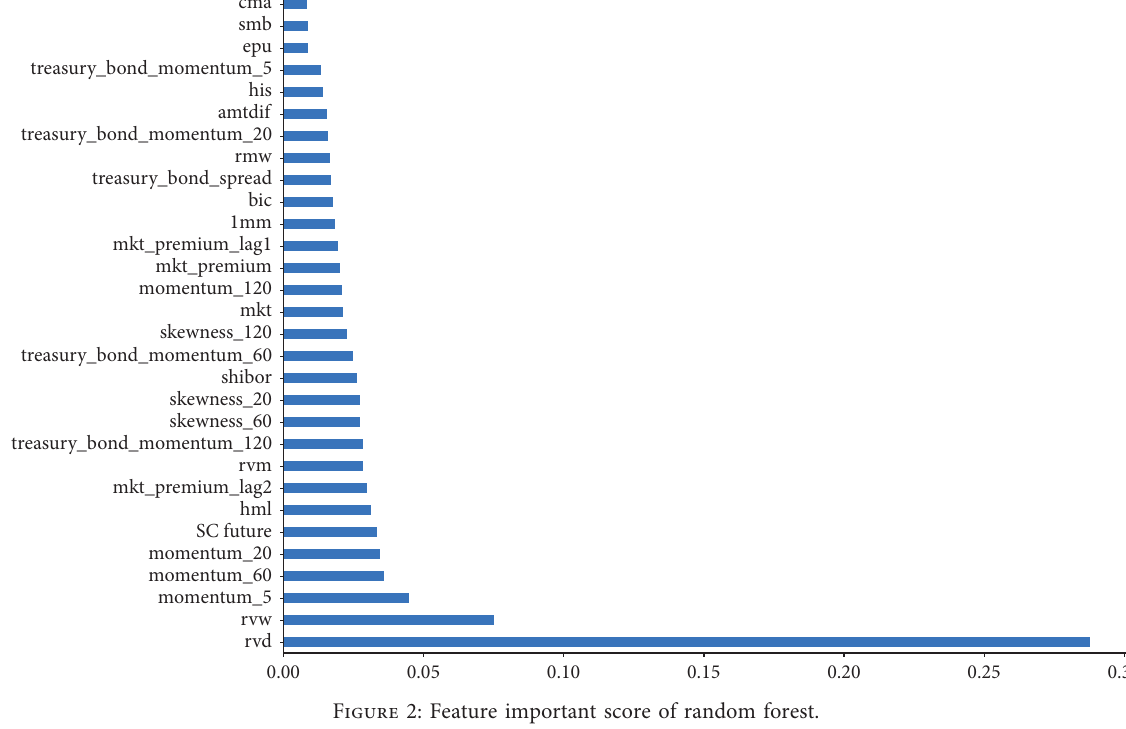
Figure 2: Feature important score of random forest.